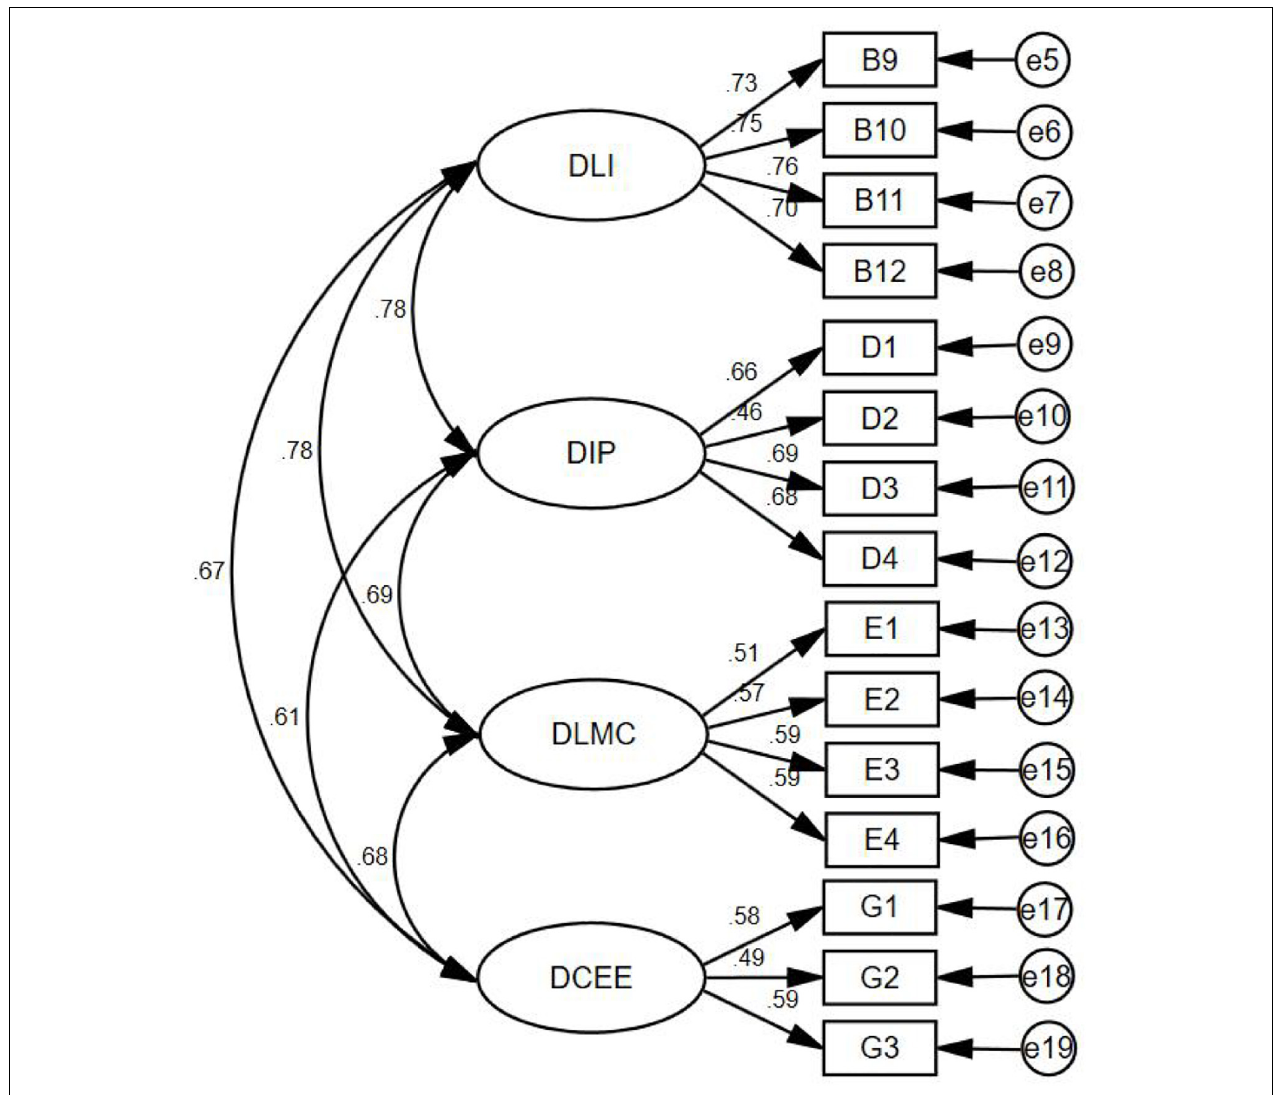
FIGURE 1 | Confirmation factor analysis (DLI, deep learning investment; DIP, deep information processing; DLMC, deep learning meta-cognitive; DCEE, deep cognitive emotional experience; PTES, perceived teacher emotional